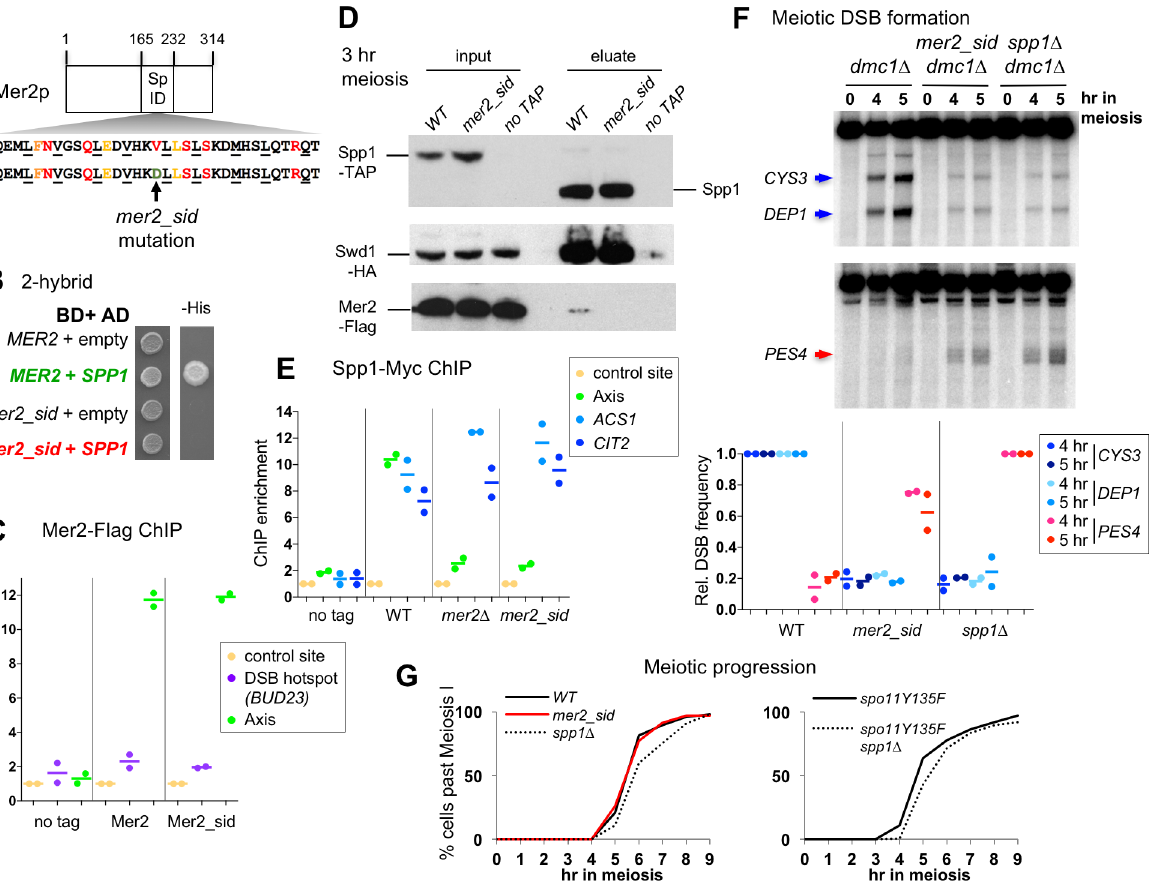
Fig 6. A mer2 point mutant affected for its interaction with Spp1 mimics the meiotic phenotype of spp1 Δ . (A) Scheme of the Mer2 protein, with its predicted coil-coil structures (Hhpred) and the Spp1 interacting domain (165–232) [17]. Below is the Mer2 protein sequence in the predicted coiled-coiled heptad structure. Buried positions required for coiled-coil pairing are underlined. Amino acids conserved and predicted to be surface- exposed are colored. The mer2_sid mutation (V195D) is indicated by an arrow. (B) 2-hybrid assays for the interaction between Mer2 and Spp1. Growth on the–His medium indicates an interaction between the two tested proteins. (C) Association of Mer2 and Mer2_sid mutant proteins with chromosome axis during meiosis (t = 3 hr) monitored by ChIP. No tag: ORD7339; Mer2-Flag: VBD1251; Mer2_sid Flag: VBD1843. Each dot represents a biological replicate and the bar indicates the mean. (D) Interaction of Spp1 with Mer2 and the Set1 complex subunit Swd1 in meiotic cells examined by Western blot. Proteins pulled down by Spp1-TAP were released in the eluate after Tev cleavage of the Tap tag. Anti-HA, anti-Flag and anti-TAP antibodies were used as indicated. MER2-FLAGSPP1-TAP SWD1-HA : VBD1745; mer2_sid-FLAG SPP1-TAP SWD1-HA : VBD1852; SPP1-TAP SWD1-HA : VBD1742. (E) Association of Spp1 during meiosis (t = 3 hr) monitored by ChIP. No tag: ORD7339; WT: VBD1187; mer2 Δ : VBD1220; mer2_sid :VBD1924. Each dot represents a biological replicate and the bar indicates the mean. (F) Meiotic DSB formation monitored in dmc1 Δ cells by Southern blot at CYS3 and DEP1 DSB (upper panel), or at the spp1 Δ -specific PES4 DSB. DSB sites are indicated by arrows. WT: ORD7354; mer2_sid : VBD1879; spp1 Δ :VBD1748. Graph shows the DSB quantification relative to the level in WT (for CYS3 , DEP1 )or spp1 Δ cells (for PES4 site). DSB were quantified at the 5 hr time point. Each dot represents a biological replicate and the bar indicates the mean. (G) Meiotic progression as assessed by DAPI staining of strains with the indicated genotype. WT: ORD7339; mer2_sid :VBD1880; spp1 Δ :VBD1769; spo11Y135F : VBD1291; spo11Y135Fspp1 Δ :VBD1233. Representative experiments are shown. See also S8 Fig.